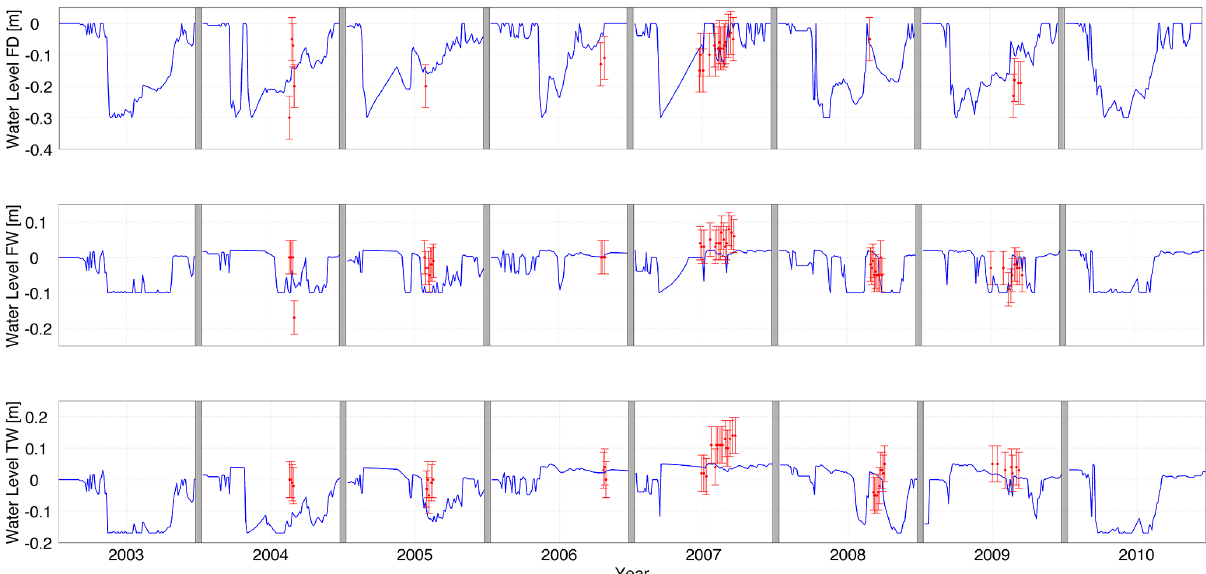
Figure 4. Water table produced by Peatland-VU compared with data, floodplain dry group (FD), floodplain wet group (FW2), and tundra wet group (TW1), 2003 to 2010. For data (red), the standard error is shown by an error bar. Note the different scales on the y